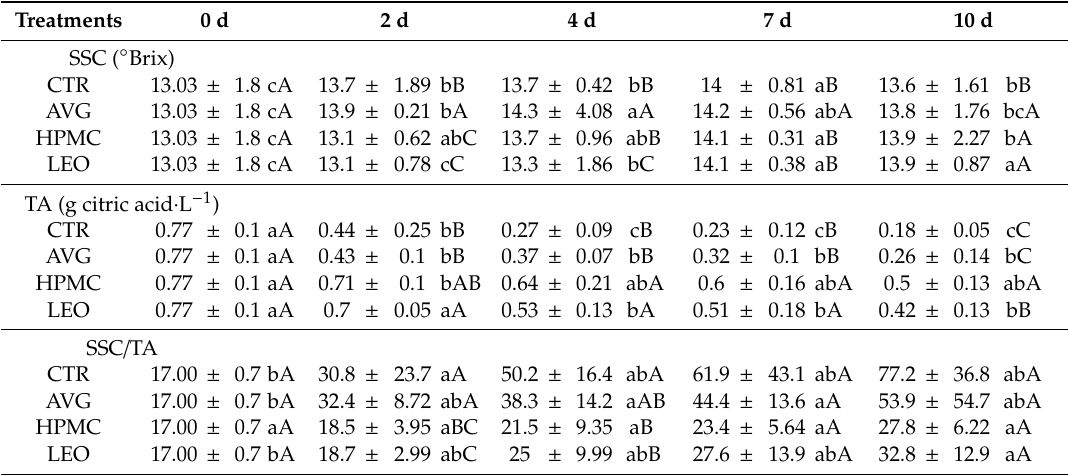
Table 1. Evolution of the soluble solids content (SSC), titratable acidity (TA) and the SSC / TA ratio on day 0 (fresh), 2, 4, 7 and